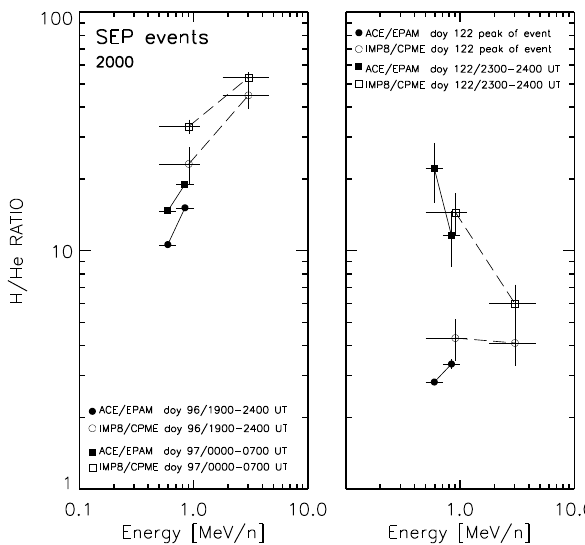
Fig. 8. H/He ratios as a function of energy/nucleon for two differ- ent times during the two SEP events shown in Fig. 5 as observed by ACE/EPAM (solid symbols) and IMP-8/CPME (open symbols). The spectrum for the peak intensity of the event on 122 has been evaluated using 1-hour averaged intensities observed at the maxi- mum intensity for each energy (i.e. at different